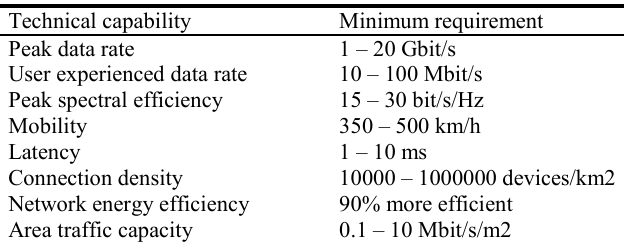
Table 1. Key minimum requirements related to technical performance for IMT-2020 radio